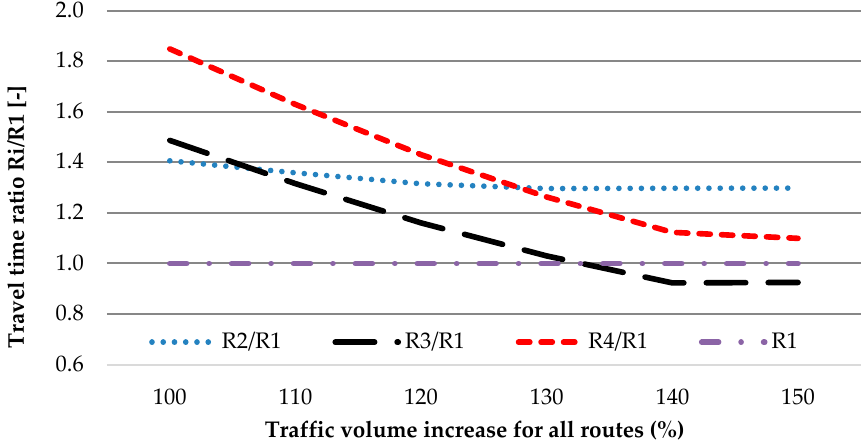
Figure 8. Travel time ratio for increase in traffic volume for all routes.